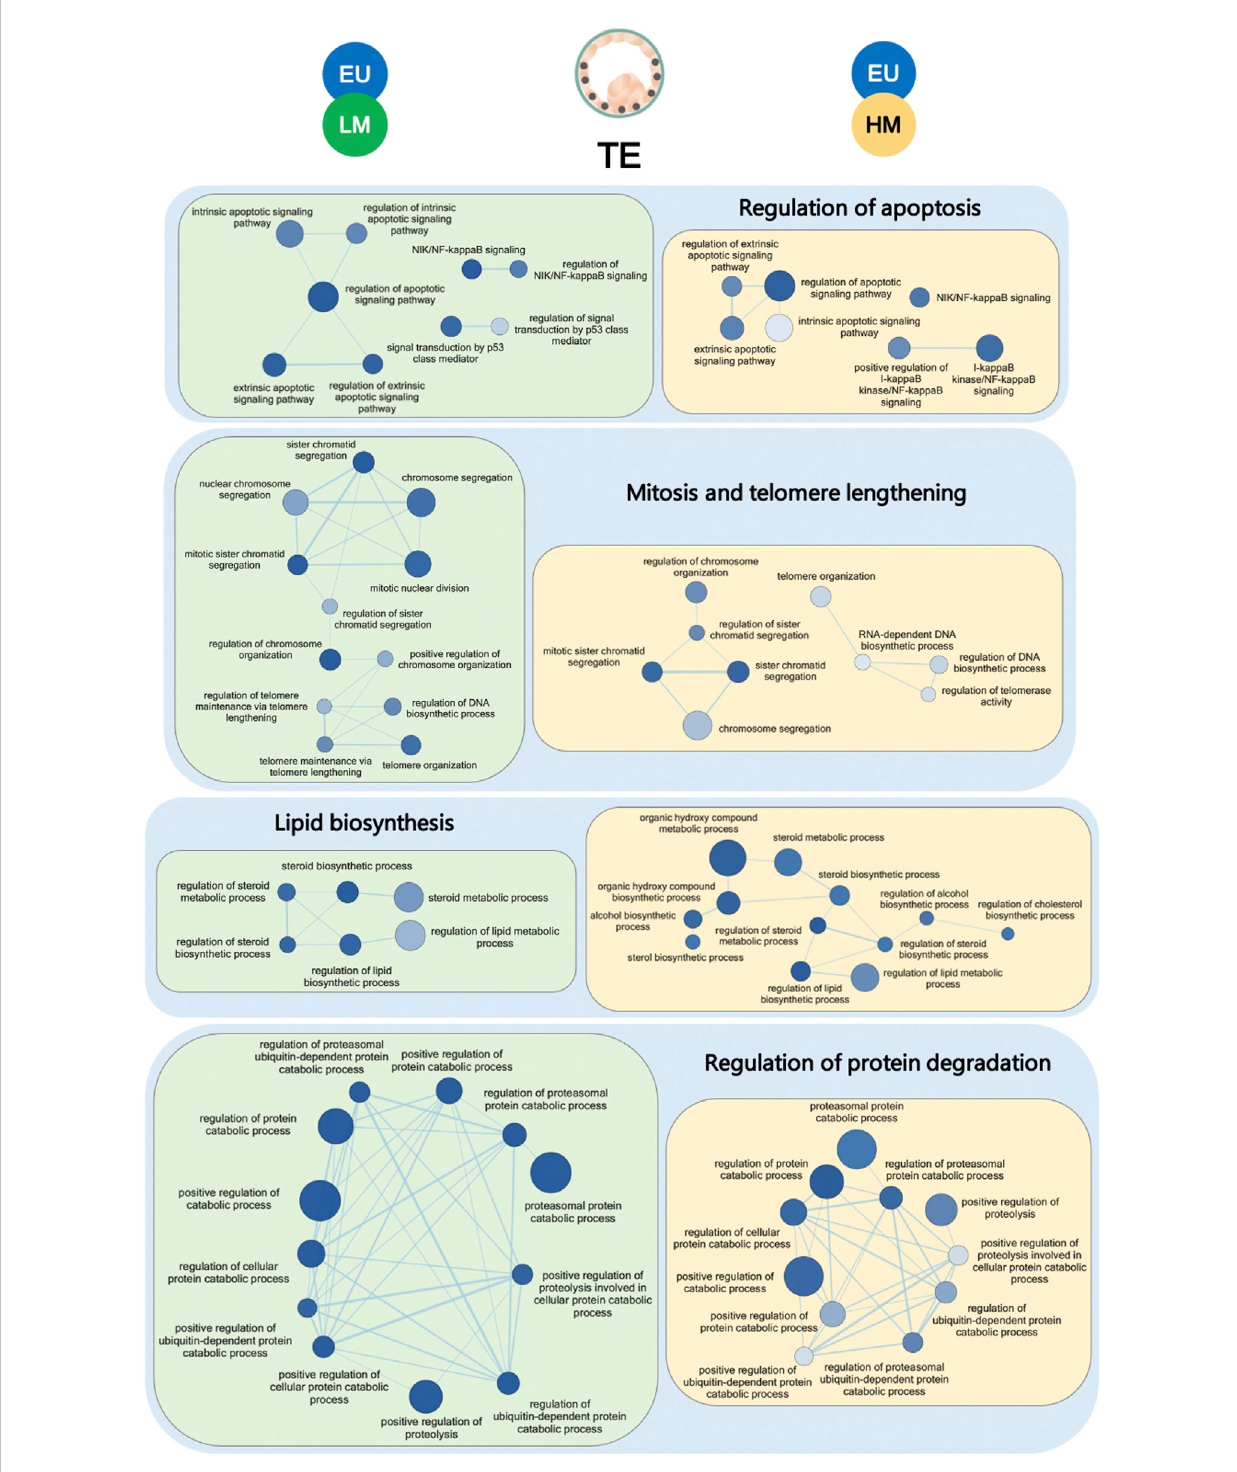
FIGURE 3 Gene set enrichment analysis of trophectoderm samples. Enrichment map of gene sets signi fi cantly downregulated in the trophectoderm (TE) of low-level mosaic embryos (LM) (green panels) and high-level mosaic embryos (HM) (yellow panels) compared to the TE of euploid (EU) embryos. Nodes represent gene ontology biological processes. Node color intensity correlates with the FDR q-value, the more intense the greater statistical signi fi cance of the difference of expression. Node size represents the number of genes in the gene set. Edges represent overlap between gene sets, and edge width represents the number of genes that